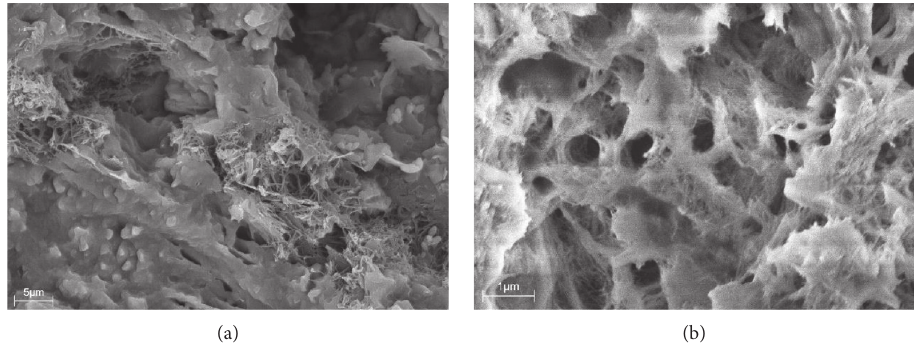
Figure 9: Micromorphology of resin modified cement sample R3.